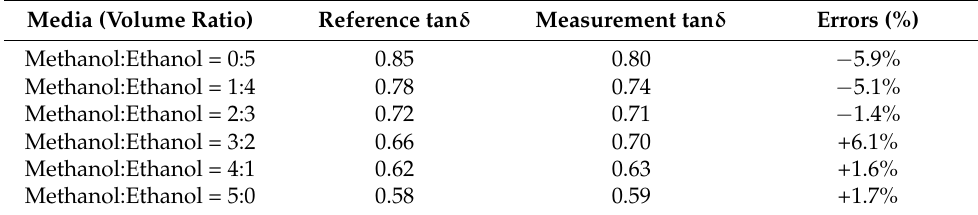
Table 3. Loss tangent of